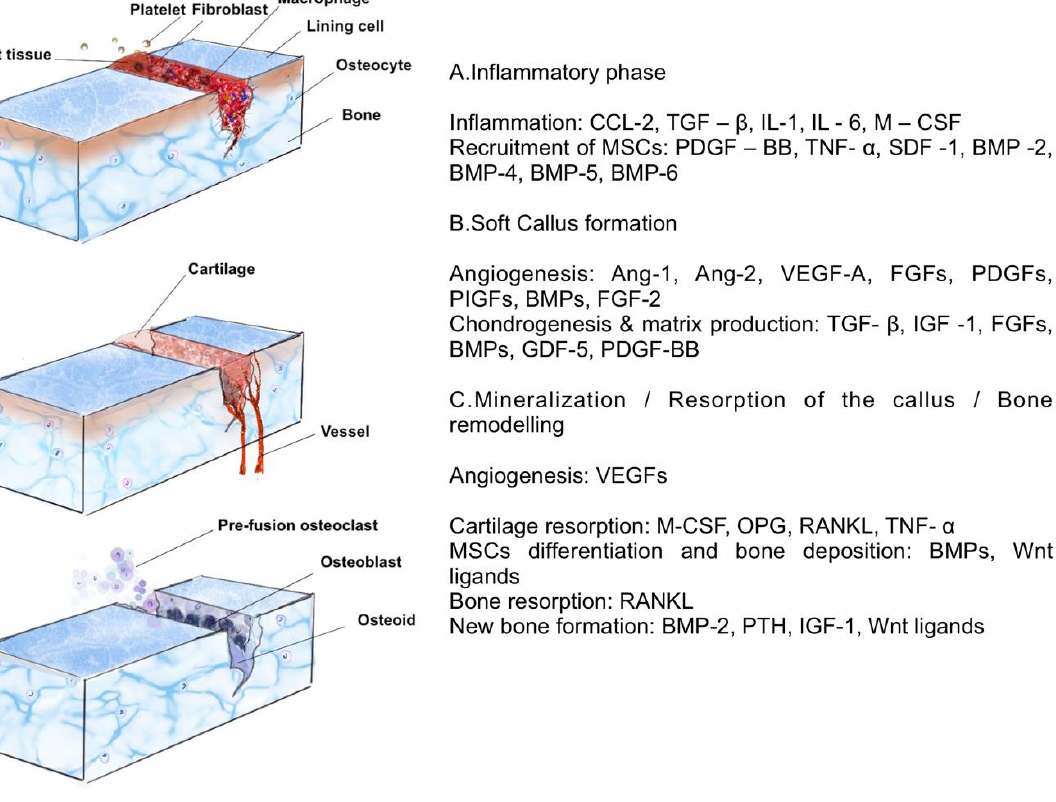
Figure 5. The temporal progression of fracture healing: healing of a fracture involves a complex series of processes which can be broadly divided into four phases, A. inflammatory phase; B. soft callus formation, C. mineralisation of callus, and bone remodelling. Each phase is regulated by key growth factors, as shown in the figure. BMP = bone morphogenetic protein, FGF = fibroblast growth factor, GDF-5 = growth / di ff erentiation factor 5, IGF-1 = insulin-like growth factor 1, M-CSF = macrophage colony-stimulating factor, OPG = osteoprotegerin, PDGF = platelet-derived growth factor, PlGF = placental growth factor, PTH = parathyroid hormone, RANKL = receptor activator of nuclear factor κ B ligand, SDF-1 = stromal cell-derived factor 1, TGF- β = transforming growth factor β , TNF- α = tumor necrosis factor α , and VEGF = vascular endothelial growth factor. Image adapted from Yague et al. [216].